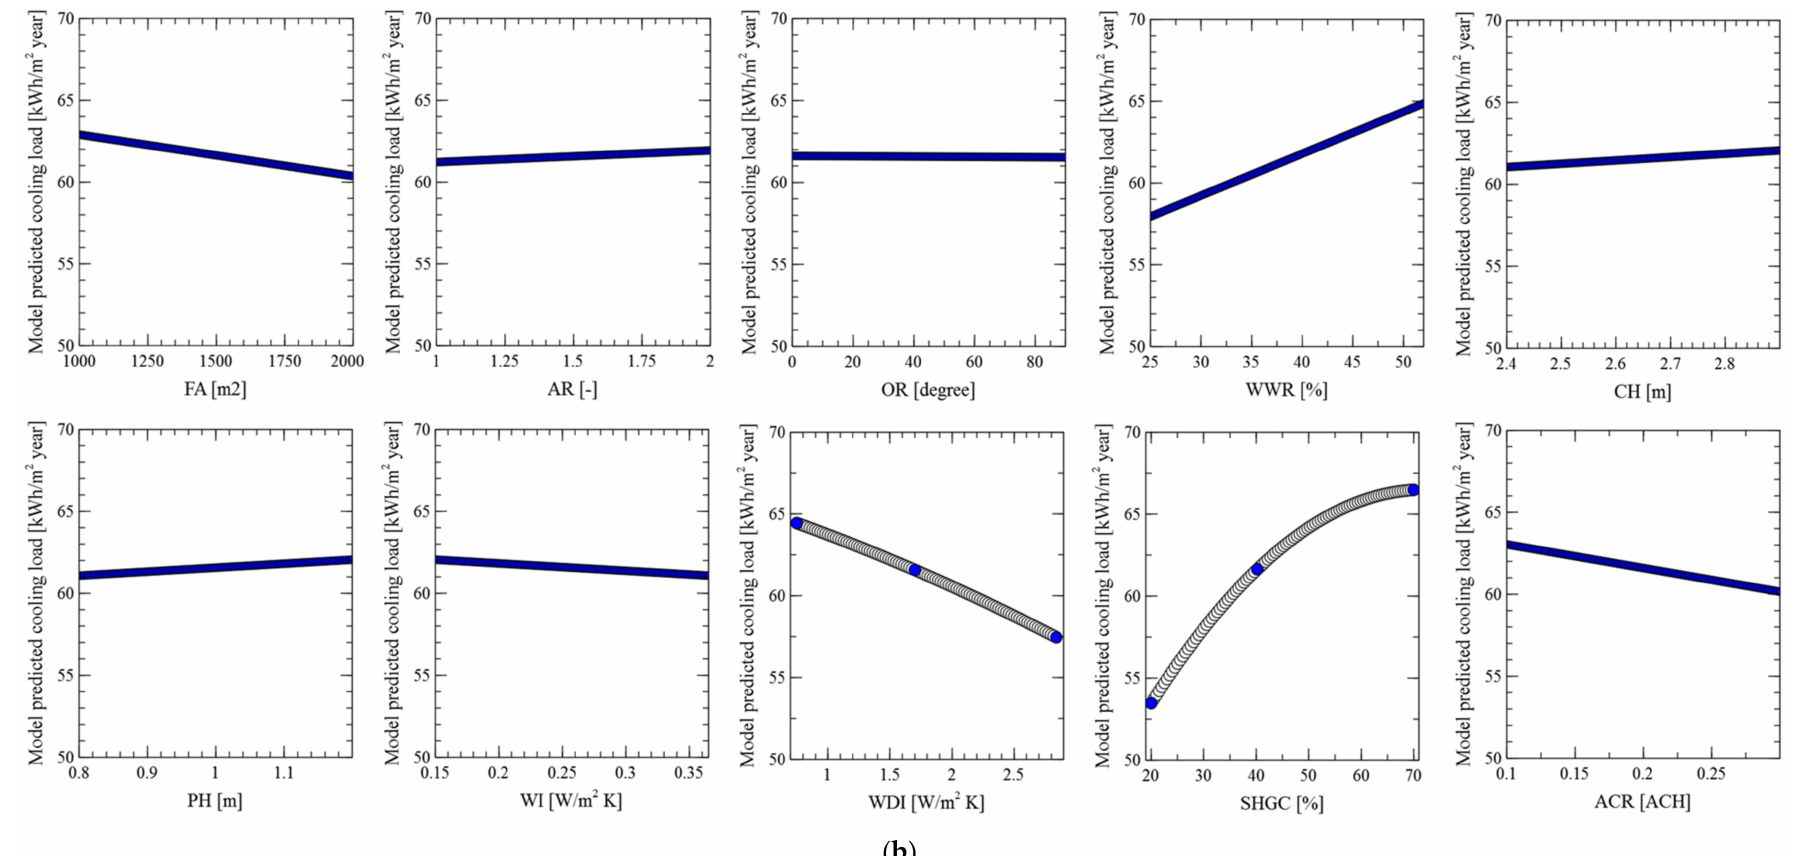
Figure 9. ( a ) The influence of design factor variations on building heating load. ( b ) The influence of design factor variations on building cooling